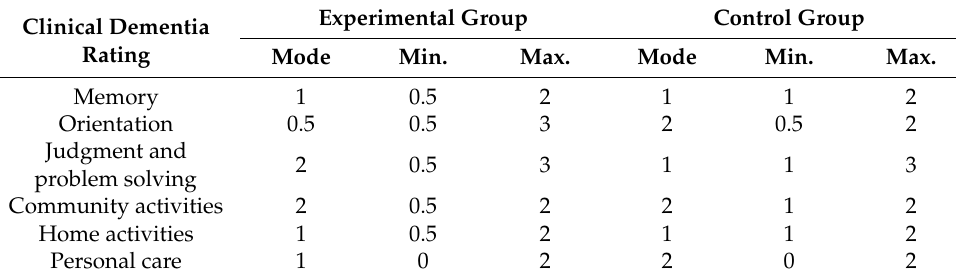
Table 2. Clinical Dementia Ratings at the baseline assessment.